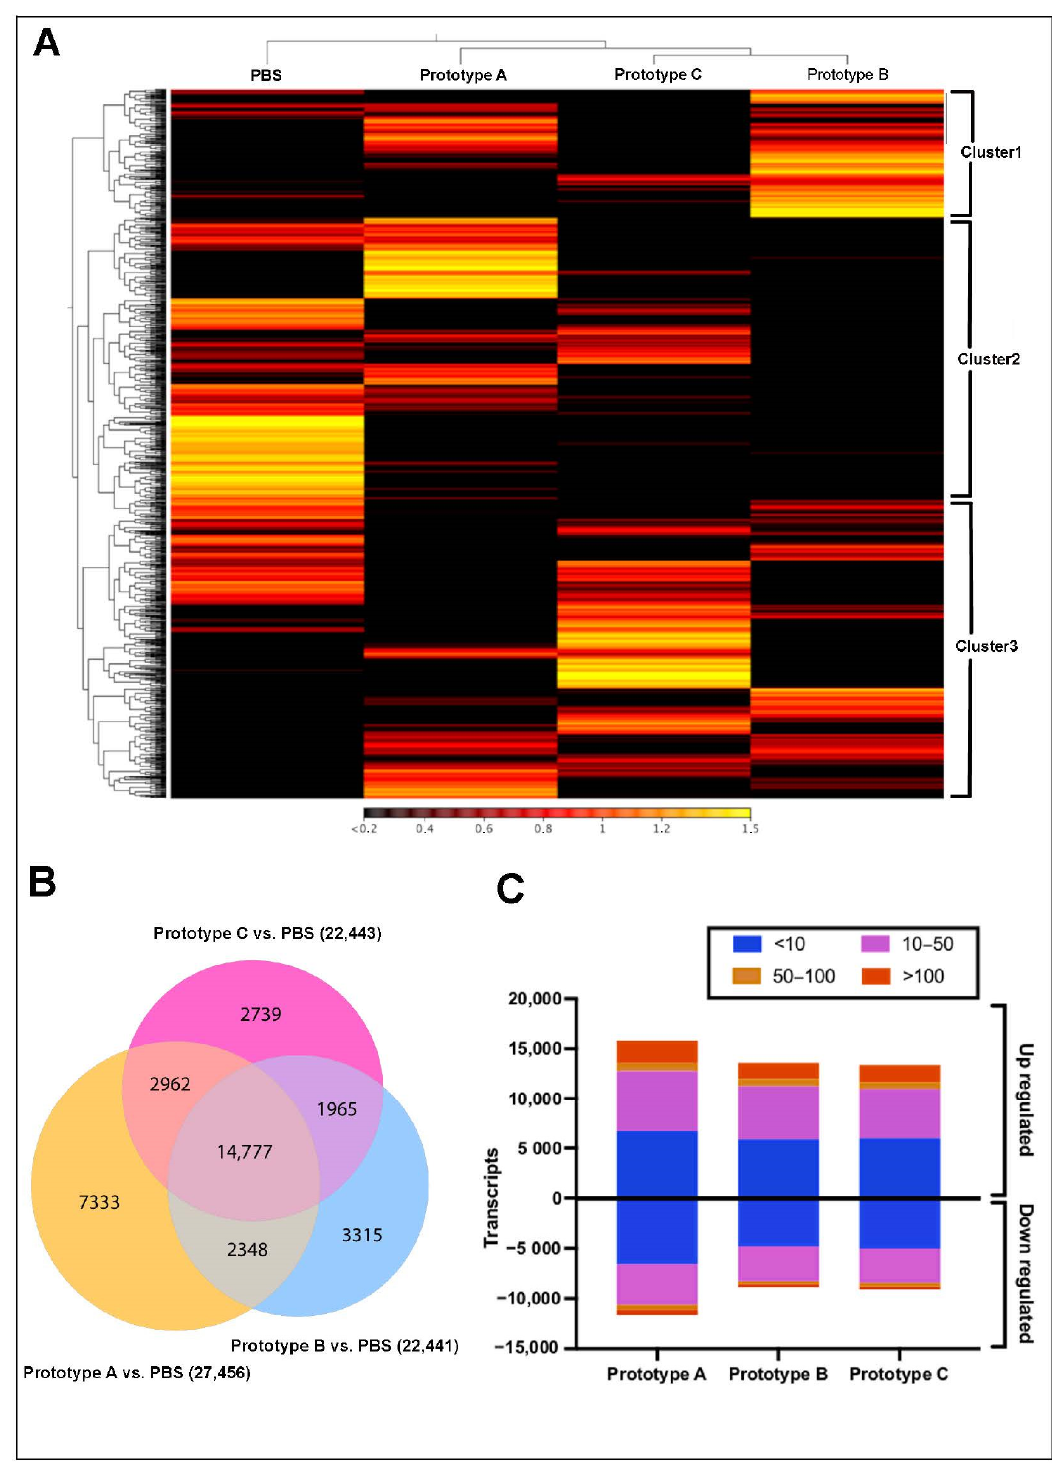
Figure 3. Transcriptomic profiling of vaccinated S. salar skin tissue. ( A ) Heatmap showing expression values expressed in TPM. ( B ) Venn diagram of contigs differentially expressed respect with the control group (FDR 4 and p -value 0.05). The number in parentheses represents the total contigs for each treatment. ( C ) Distribution of fold change values in each experimental group. Table 2. Annotation of the differentially expressed contigs in skin tissue of vaccinated S. salar . Heatmap indicates the levels of regulation for each gene with blue at the top and red at the bottom. Red arrows indicate gene downregulation, and green arrows indicate upregulation.